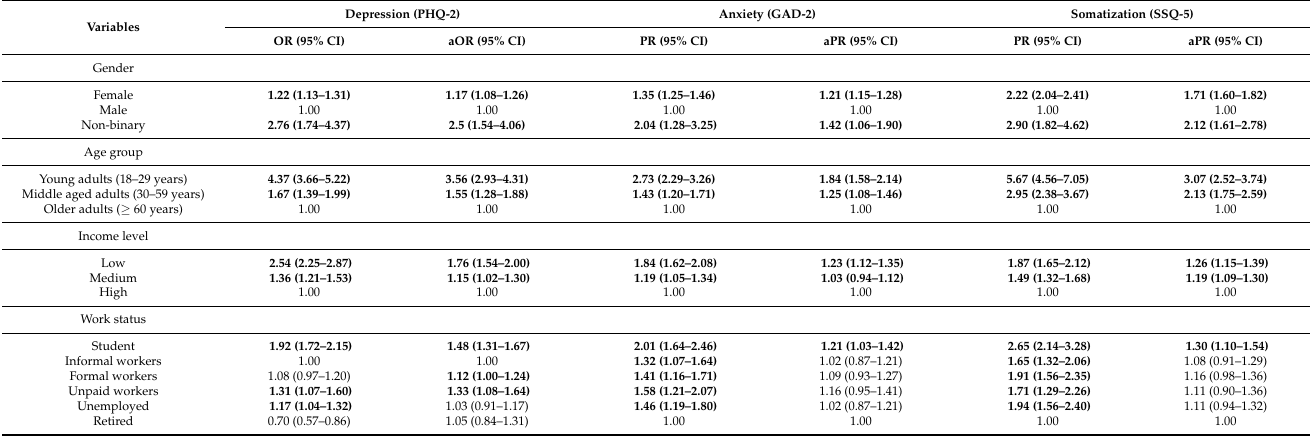
The specific results of the generalized linear model for the social determinants of health associated with each dimension affecting mental health are shown in Table 3. Table 3. Observed and adjusted associations of social determinants of health with mental health